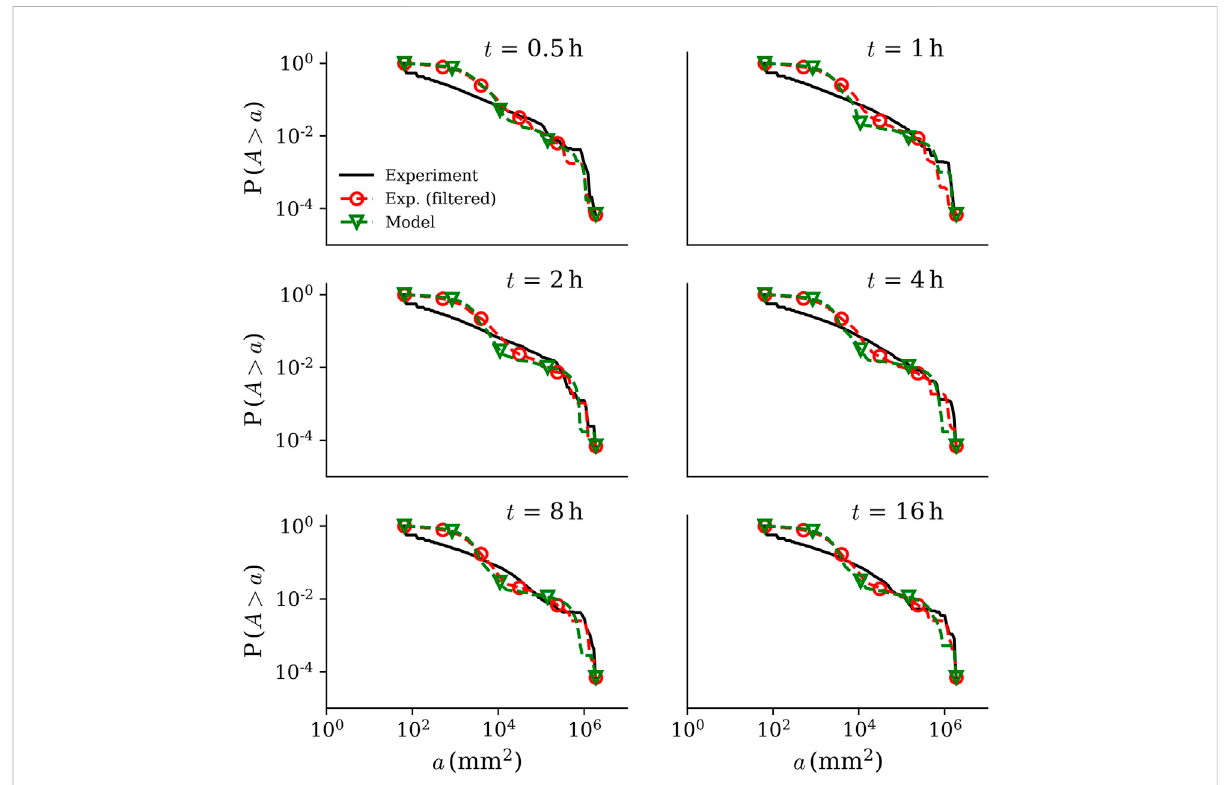
FIGURE 11 Exceedanceprobabilityofdrainageareaforthemodel,originalexperimentanditslow-pass fi lteredmorphology.Themodelresultsand fi ltered experimental results agree at all